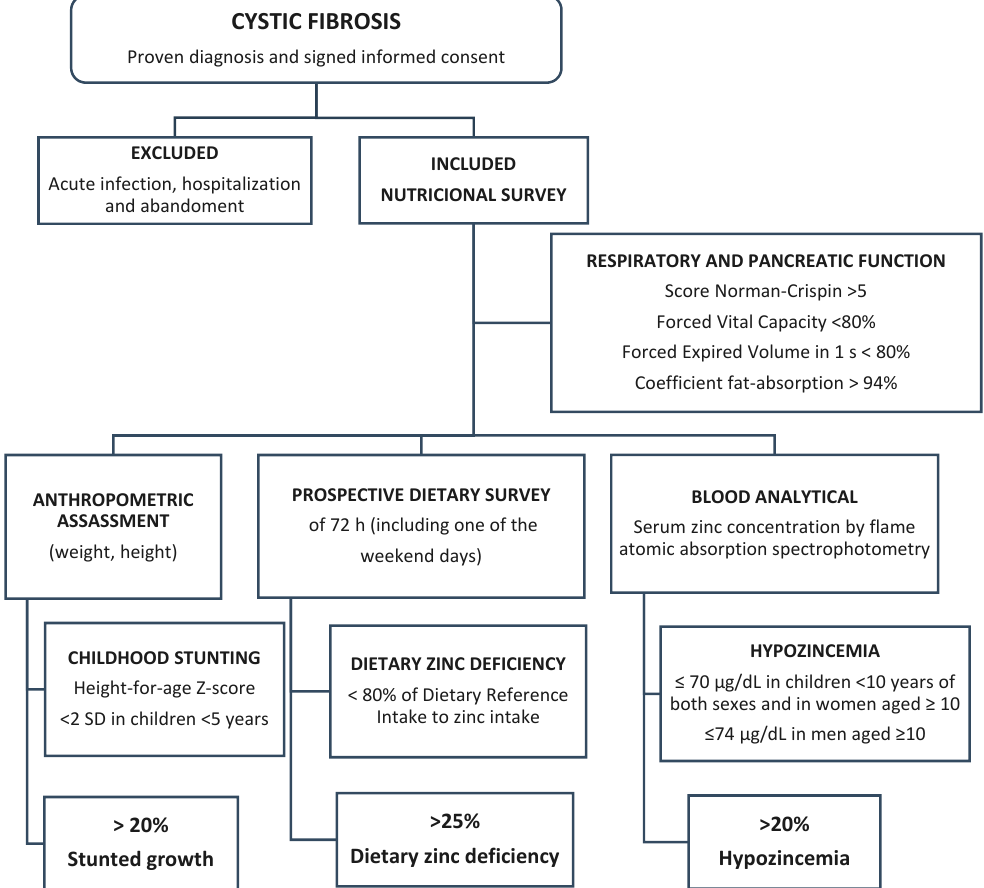
Figure 1. Graphic of design of the cross-sectional study to value the risk of zinc deficiency. Table 1. Baseline Characteristics of the Subjects (N = 17 *).